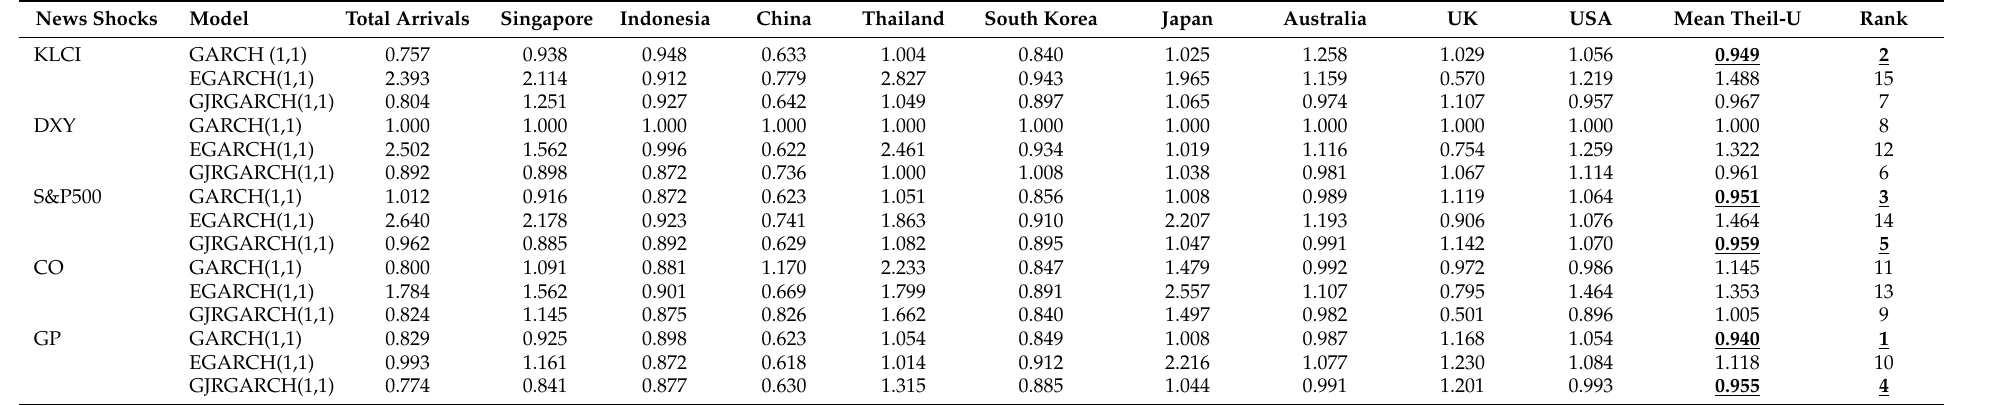
Table 13. Tourism demand volatility forecasting methods based on RMSE for out-of-sample one-step-ahead forecasting. News